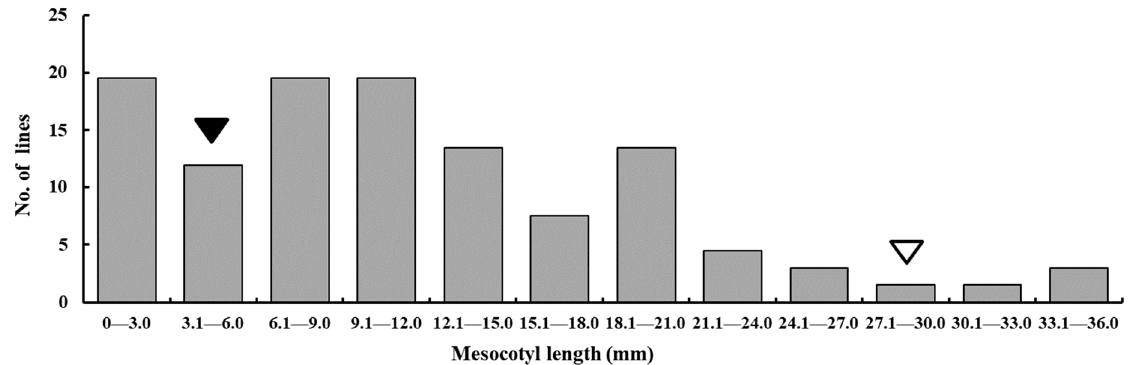
Figure 4. Frequency distribution of the mesocotyl length of plants within the F 2 segregating popu- lation. The black and white triangles represent the mean mesocotyl lengths of the Nip and CSL127 lines, respectively.